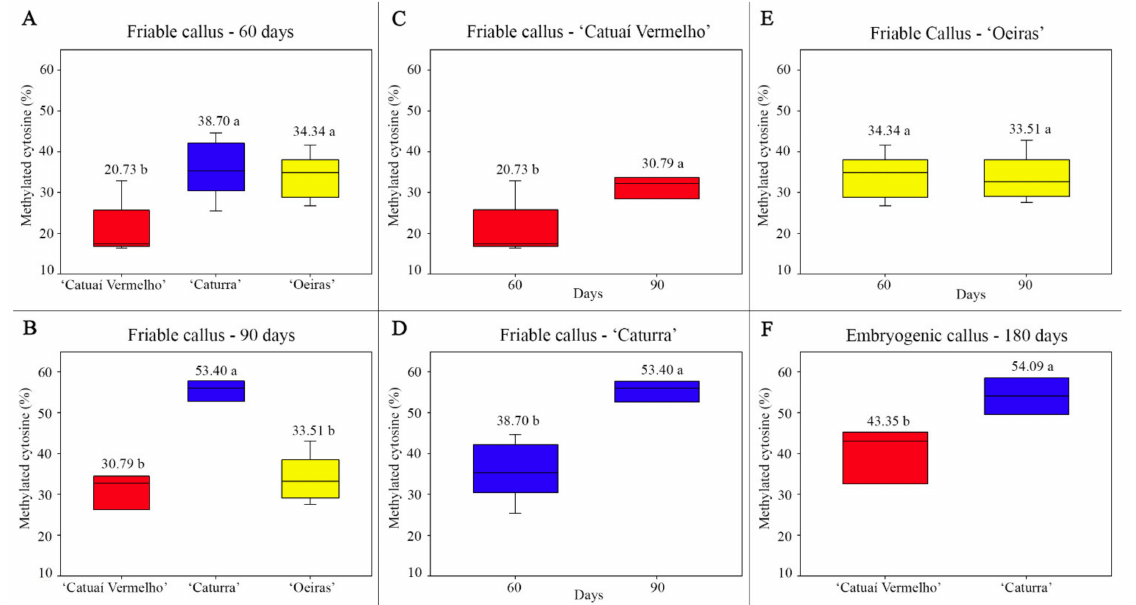
Figure 4. Levels of global methylation of genomic DNA in C. arabica lines during ISE. ( A ) Comparison of the methylated cytosine level between the friable callus of ‘Catua í Vermelho’, ‘Caturra’ and ‘Oeiras’ at 60 days. ( B ) Comparison of the methylated cytosine level between the friable callus of ‘Catua í Vermelho’, ‘Caturra’ and ‘Oeiras’ at 90 days. ( C ) Comparison of the methylated cytosine level in friable callus of ‘Catua í Vermelho’ at 60 and 90 days. ( D ) Comparison of the methylated cytosine level in friable callus of ‘Caturra’ at 60 and 90 days. ( E ) Comparison of the methylated cytosine level in friable callus of ‘Oeiras’ at 60 and 90 days. ( F ) Comparison of the methylated cytosine level between the embryogenic callus of ‘Catua í Vermelho’ and ‘Caturra’ at 180 days. Mean values followed by the same letter do not present a significant difference.